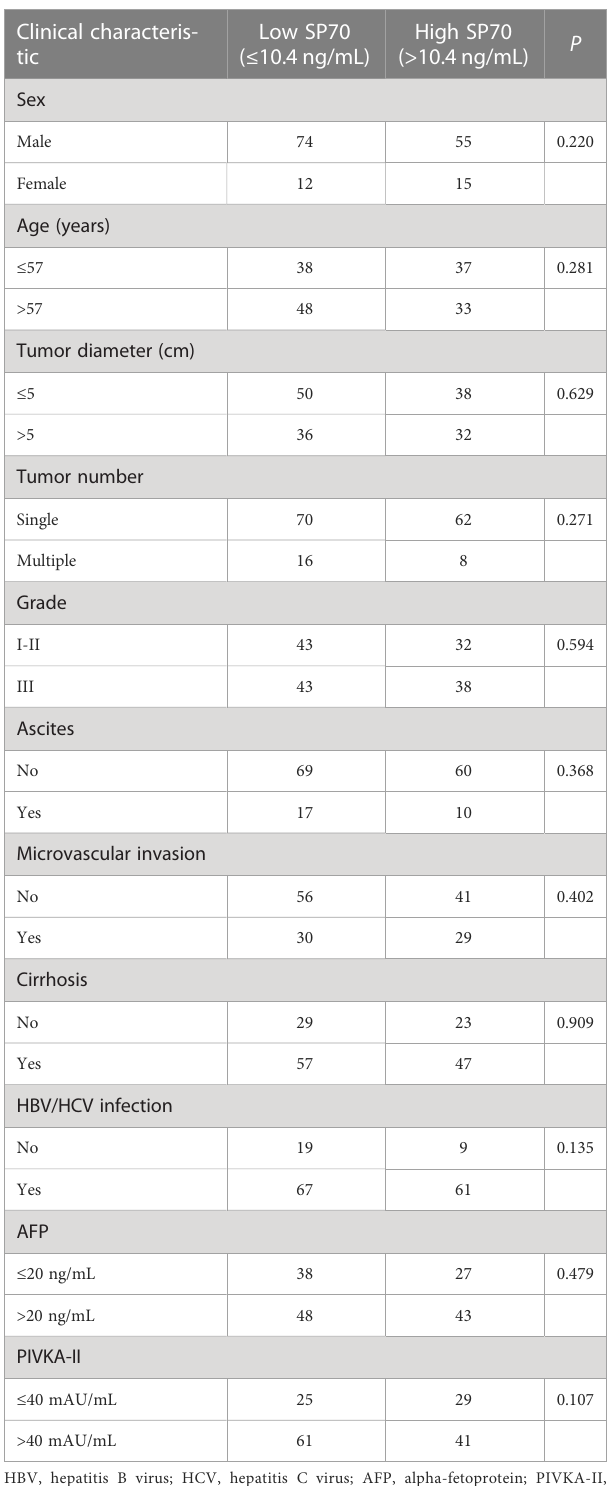
TABLE 3 Clinical and biological features of HCC patients undergoing resection according to the preoperative serum level of SP70. Clinical